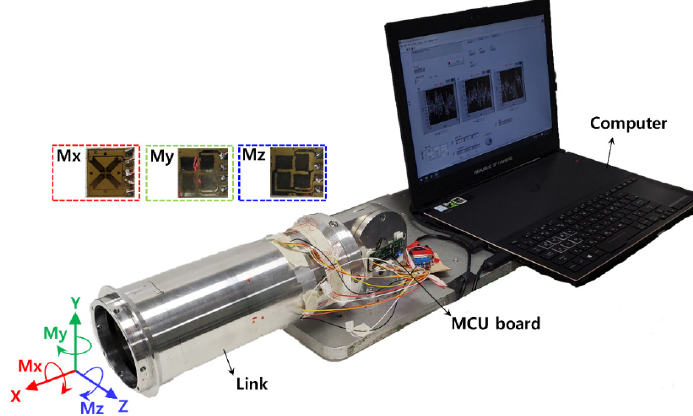
Figure 4. Experimental setup for calibration and performance.